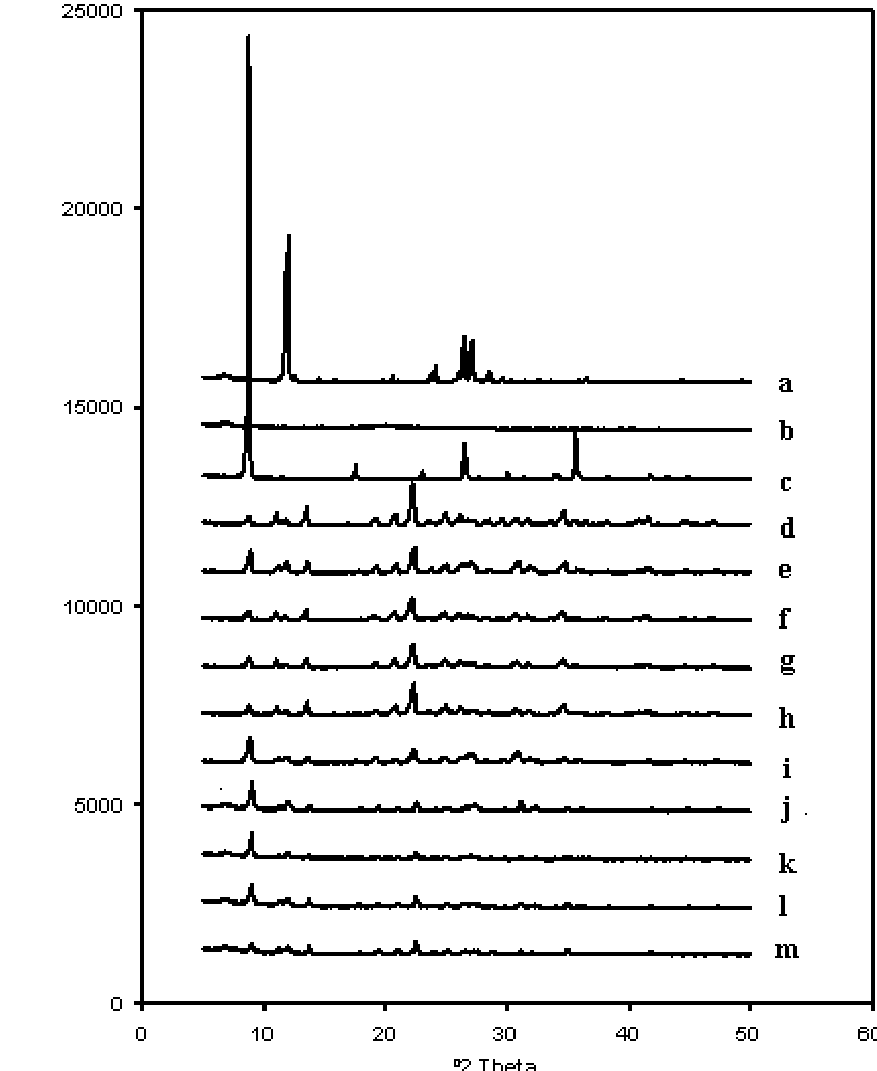
Figure 1. X-ray diffraction patterns of caffeine (a), chitosan (b), sodium acetate (c) and freeze-dried formulations L1 (d), L2 (e), L3 (f), L4 (g), L5 (h), L6 (i), L7 (j), L8 (k), L9 (l), L10 (m) prepared with acetate buffer pH =